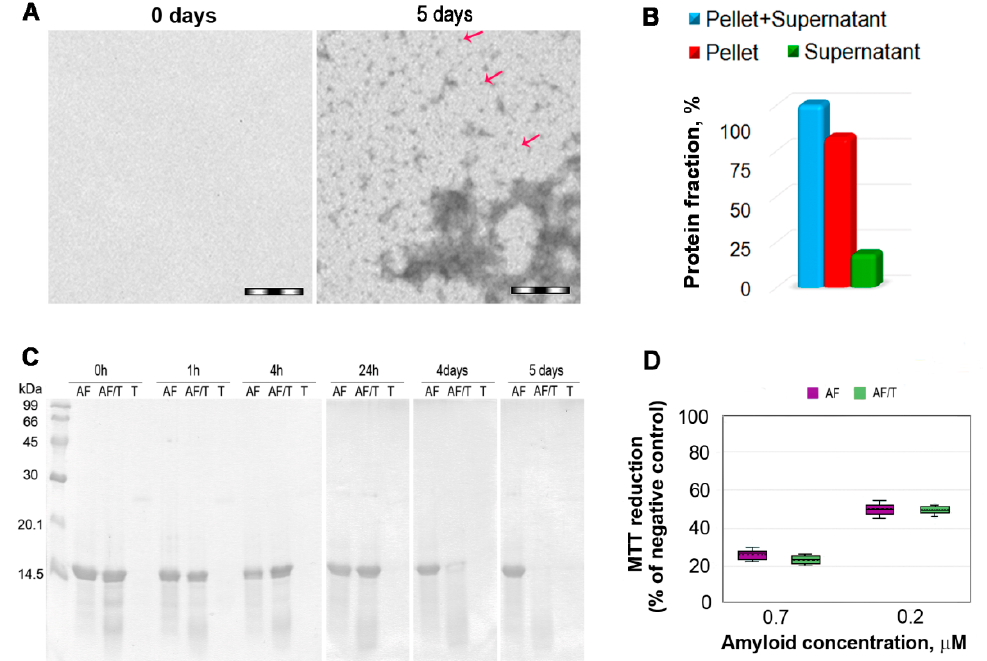
Figure 2. Stability and inhibitory effect on cells of exposed to trypsin amyloid fibrils formed from lysozyme at pH 7. ( A ) The electron micrographs of supernatant collected by centrifugation of amyloid fibrils before and five days after the addition of trypsin. Scale bars are equal to 200 nm. The estimated size of aggregates corresponds to 20 (shown by red arrows) or more monomeric protein molecules as evaluated by ImageJ. ( B ) Redistribution of the protein between supernatant and pellet obtained by centrifugation of amyloid fibrils treated with trypsin. ( C ) Trypsin-induced degradation of lysozyme amyloid fibrils detected by SDS-PAGE under denaturing conditions. The amyloid fibrils alone (AF), in the presence of trypsin (AF/T) and trypsin (T) solutions, were incubated in PBS at 37 ◦ C, and aliquots were taken at different times. Molecular weight of lysozyme and trypsin is 14.3 and 23.3 kDa, respectively. ( D ) Dose-dependent inhibition effect of amyloid fibrils on HeLa cells determined by MTT assay. Cells were exposed to amyloid fibrils, intact (AF) or five days after the addition of trypsin to the sample (weight ratio of fibrils to trypsin was kept at 7.5/1) (AF/T), at indicated concentrations for 24 h. Data are expressed as medians and interquartile ranges, whiskers denote 1.5 × IQR. Experiments were repeated at least three times with similar results.